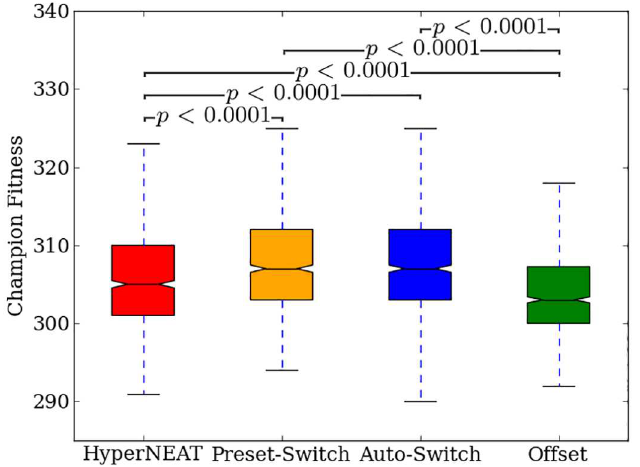
Fig 13. Final fitness for all methods on the bit mirroring experiment. The fitness of run championsafter 2,000 generationspooledacross all regularities of the bit mirroring problem.